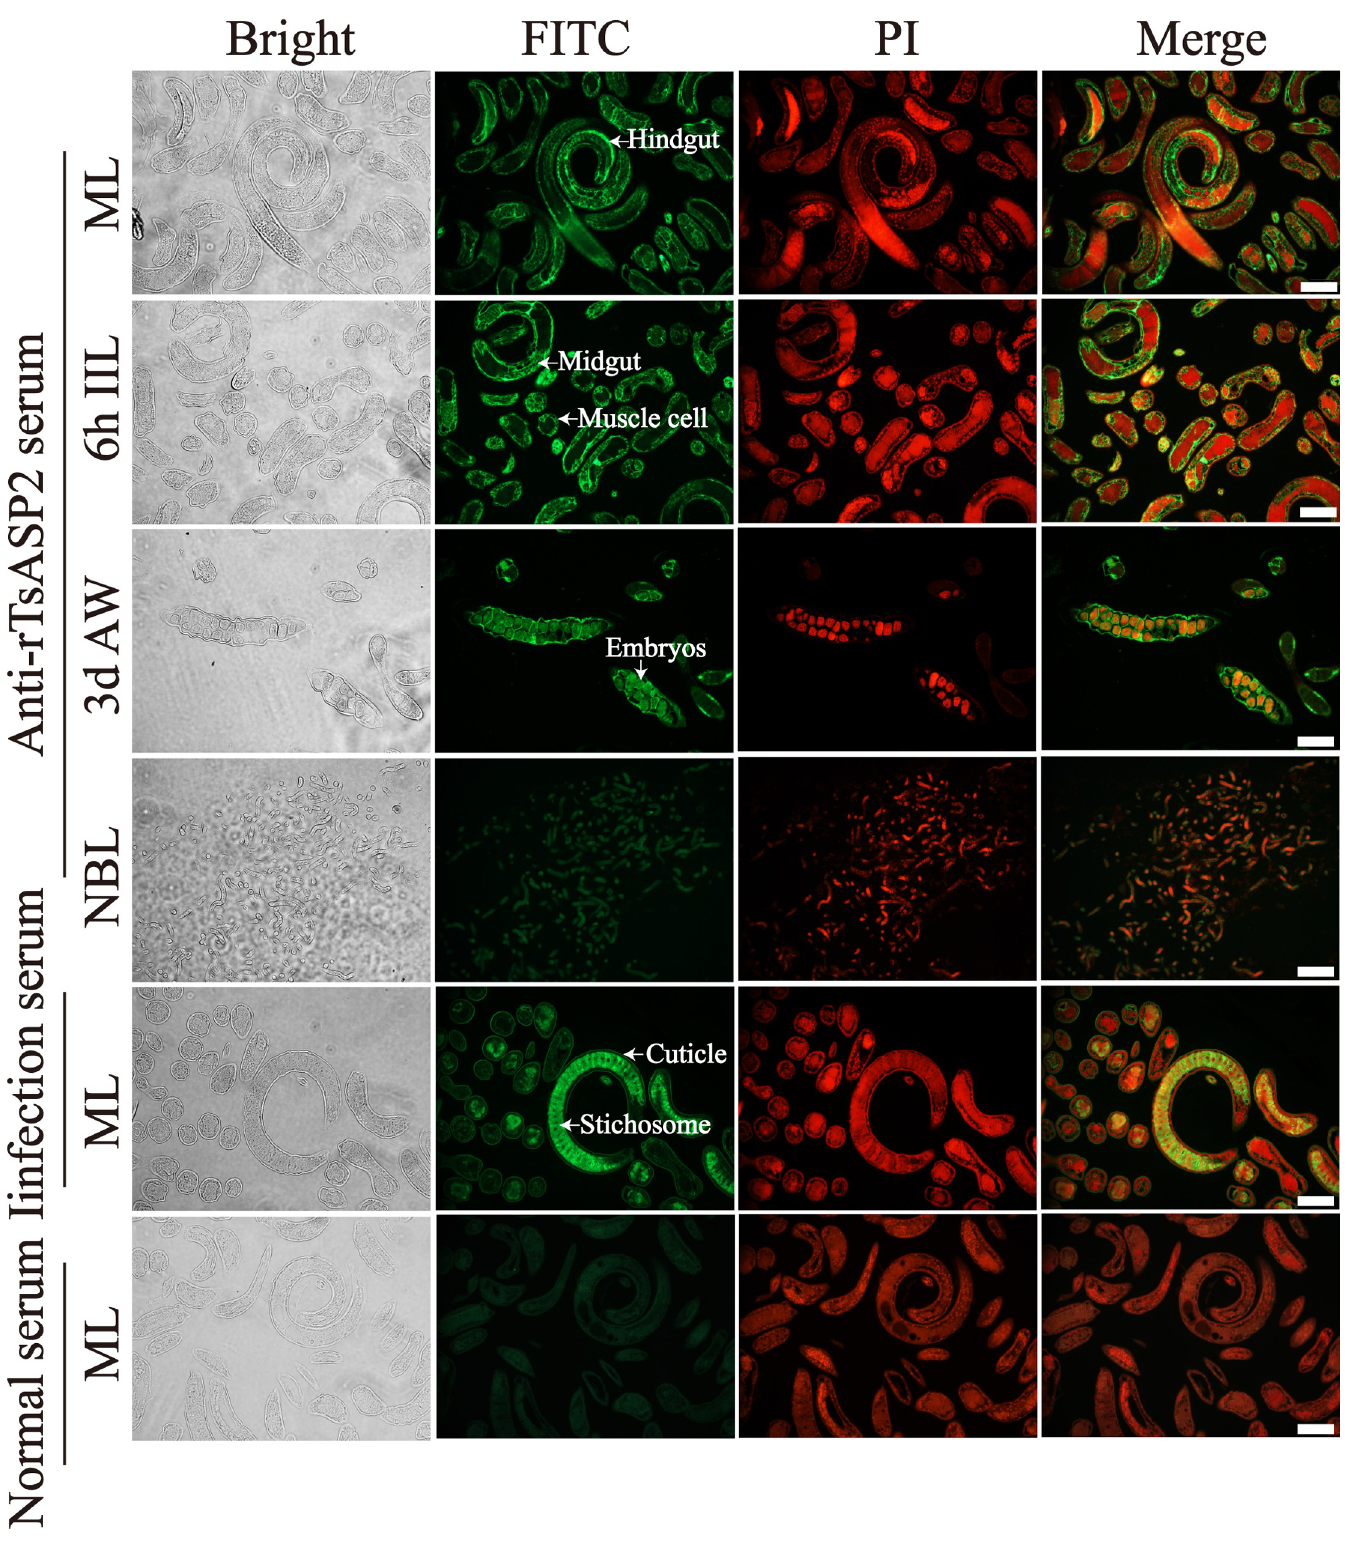
Fig 3. Immunofluorescent analysis of TsASP2 location in various worm phases. Intense green staining was observed in the midgut, hindgut and muscle cells of ML and 6-h IIL, as well as around intrauterine embryos of female adults; no immuno-staining was observed in NBL; ML recognition by infection serum as a positive control and normal serum as a negative control. The cell nuclei were stained red with propidium iodide (PI). Scale bars: 50 μ m.